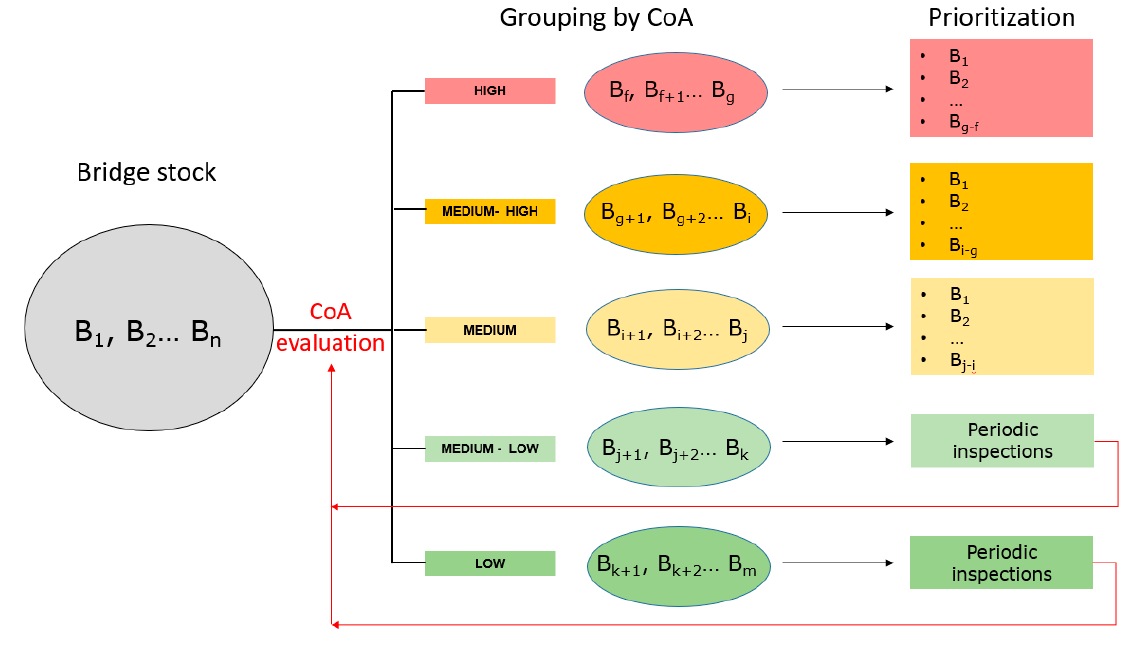
Figure 12. Prioritization of bridges in a stock.